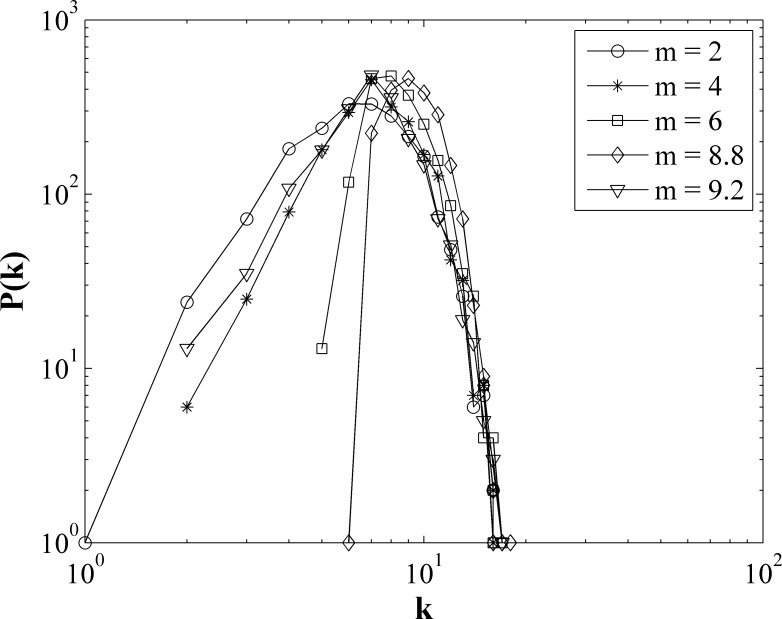
The networks degree distributions with different m values for r = 15 on original network of average degree k = 6.